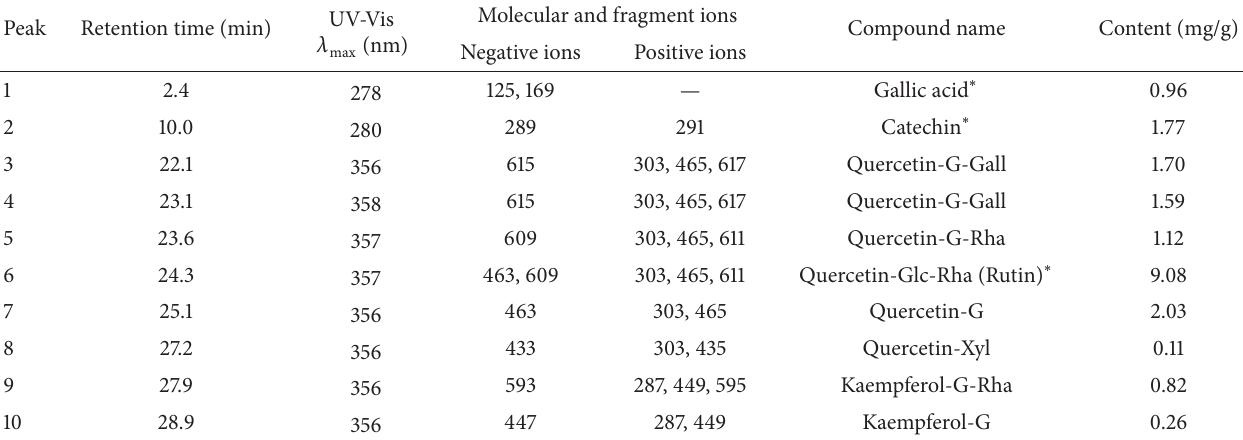
Table 1: Phytochemicals identified from the leaf extract of Ximenia caffra .